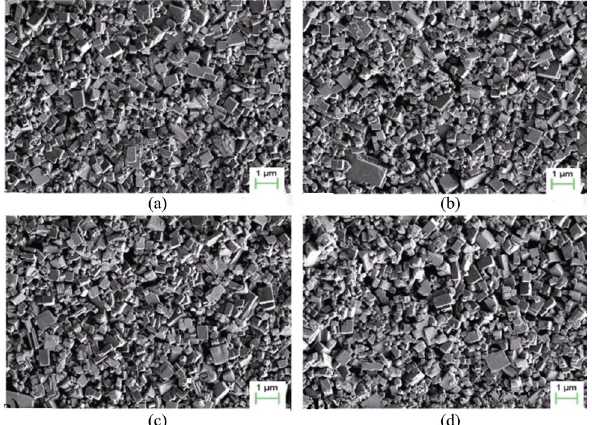
Fig. 1 SEM micrographs of KNNS–0.04BNKZ– x Sm ( x = 0.0005, 0.001, 0.002, and 0.004) ceramics.